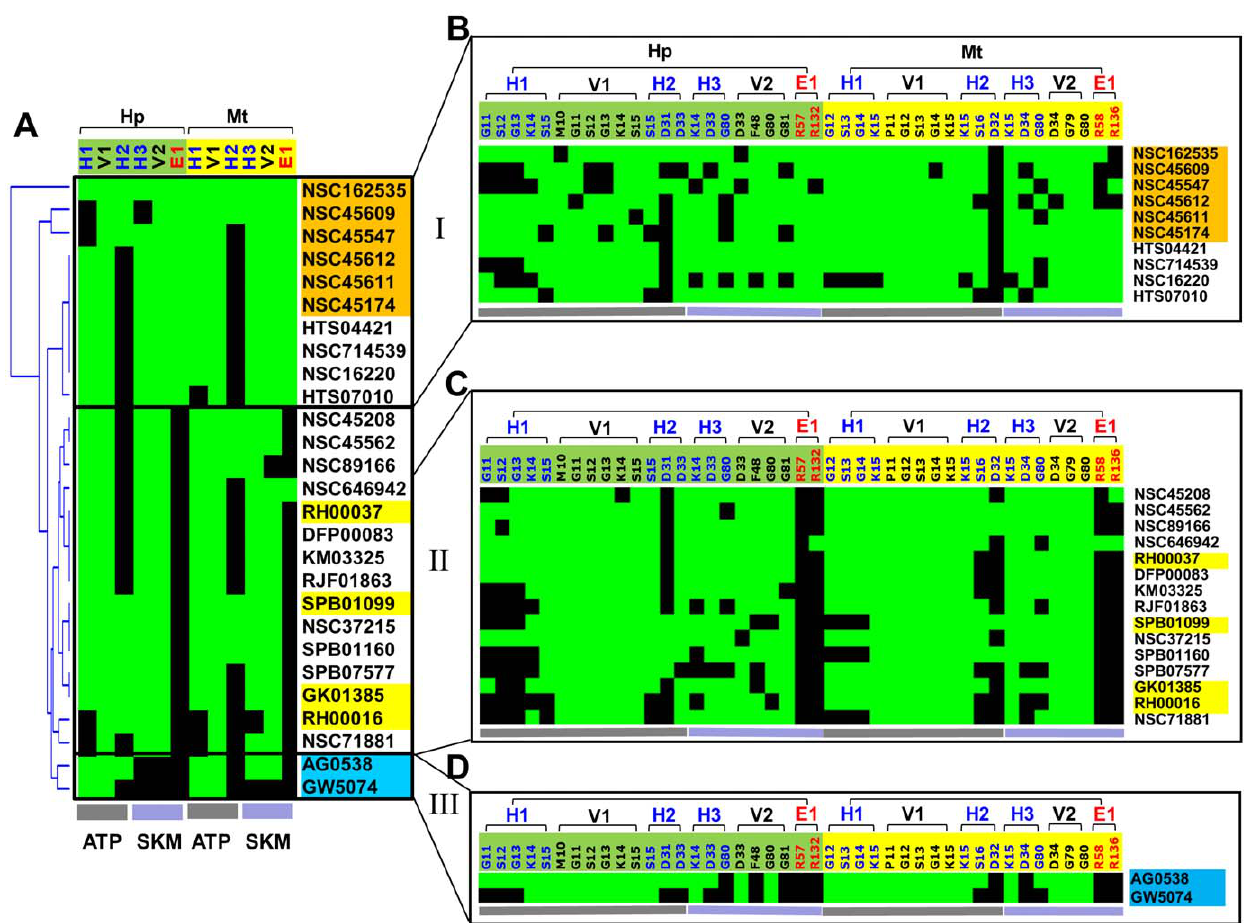
Figure 3. Interaction profiles between selected anchor residues and 27 tested compounds. (A) Anchor profile of tested compounds on shikimate kinases. (B) Group I: NCI compounds (orange). (C) Group II: Maybridge compounds (yellow). (D) Group III: kinase inhibitors (cyan). The NCI compounds consistently occupy anchors E1 and V2 at both ATP and shikimate sites. The NCI compounds except NSC45174 are competitive inhibitors with both ATP and shikimate. For the Maybridge compounds, none form electrostatic interactions with R57 and R132 on the consensus anchor E1. The two kinase compounds are located at the ATP site, which fact is consistent with the kinetic results that reveal that these compounds exhibited competitive inhibition with ATP and noncompetitive inhibition with shikimate.